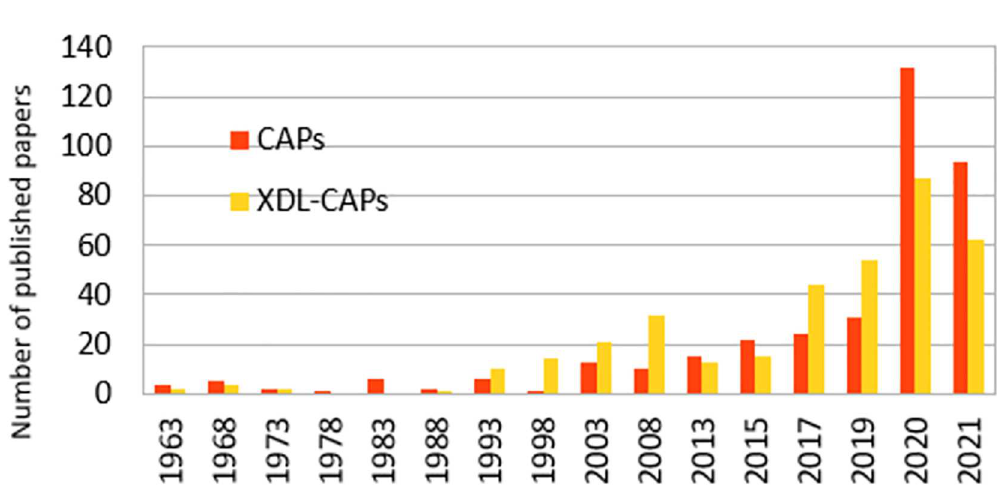
Fig 5. Published papers referring to CAPs and explainable DL with reference to CAPs.